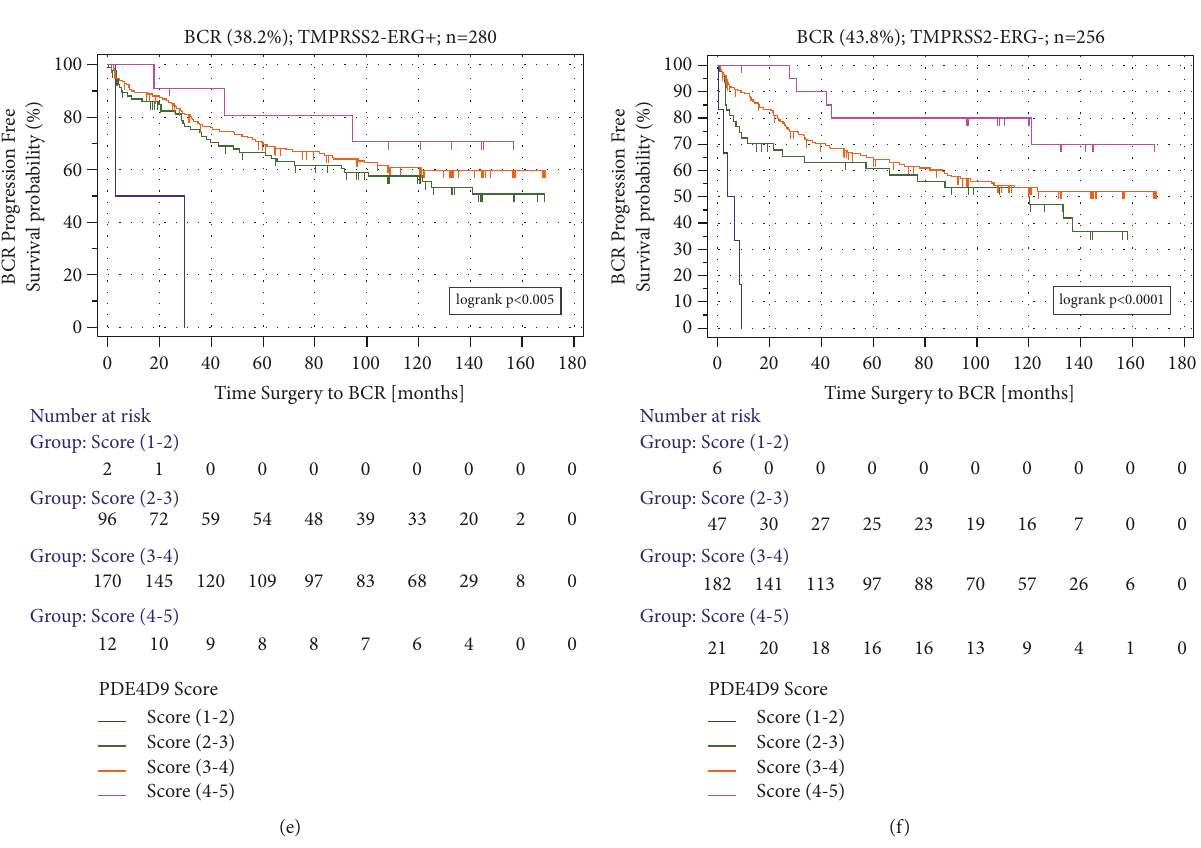
Figure 1: Kaplan-Meiersurvival analysis of the timeto PSA relapse(endpointBCR: biochemicalrecurrence)in theRP patientcohort(n=536) for the PDE4D5, PDE4D7, and PDE4D9 scores. (a) Kaplan-Meier analysis of the BCR free survival of the PDE4D7 score in TMPRSS2-ERG positive tumours (n=280). (b) Kaplan-Meier analysis of the BCR free survival of the PDE4D7 score in TMPRSS2-ERG negative tumours (n=256). (c) Kaplan-Meier analysis of the BCR free survival of the PDE4D5 score in TMPRSS2-ERG positive tumours (n=280). (d) Kaplan- Meier analysis of the BCR free survival of the PDE4D5 score in TMPRSS2-ERG negative tumours (n=256). (e) Kaplan-Meier analysis of the BCR free survival of the PDE4D9 score in TMPRSS2-ERG positive tumours (n=280). (f) Kaplan-Meier analysis of the BCR free survival of the PDE4D9 score in TMPRSS2-ERG negative tumours (n=256). Censored patients are indicated by vertical bars. PDE4D5, PDE4D7, and PDE4D9 score categories were defined as PDE4D5/7/9 (1-2): PDE4D5/7/9 scores (1 to < 2); PDE4D5/7/9 (2-3): PDE4D5/7/9 scores (2 to < 3); PDE4D5/7/9 (3-4): PDE4D5/7/9 scores (3 to < 4); PDE4D5/7/9 (4-5): PDE4D5/7/9 scores (4 to <